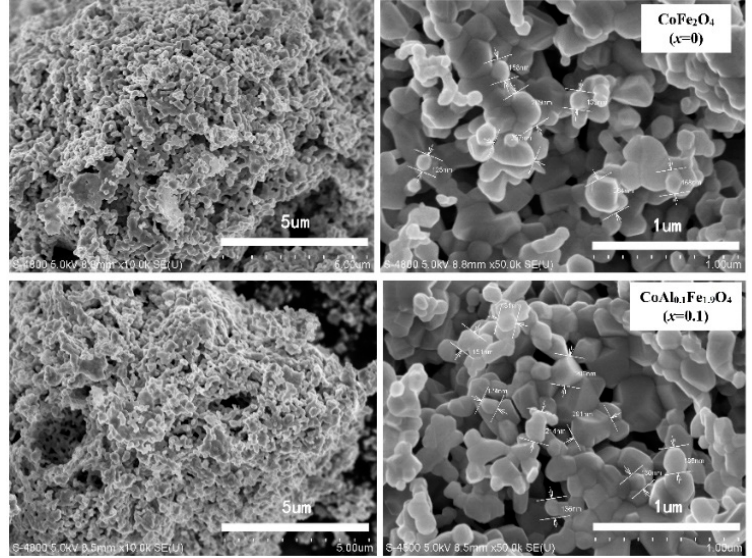
Figure 4. Scanning electron microscopy (SEM) micrographs of CoFe 2 O 4 ( x = 0) and CoAl 0.1 Fe 1.9 O 4 ( x = 0.1) calcined at 1000 °C.